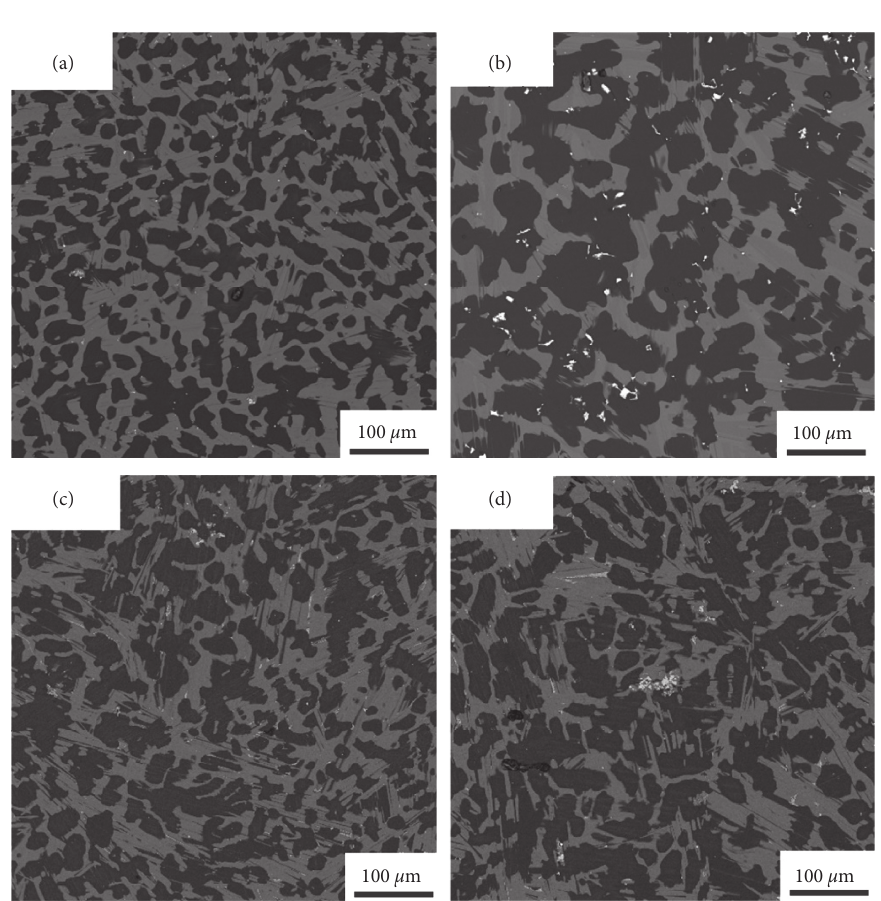
Figure 3: BSE images of as-homogenized (a) MYZ, (b) MYZC, (c) MYZN, and (d) MYZCN